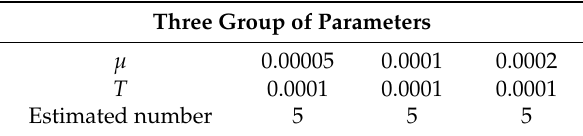
Table 4. The results of estimated endmember number with different